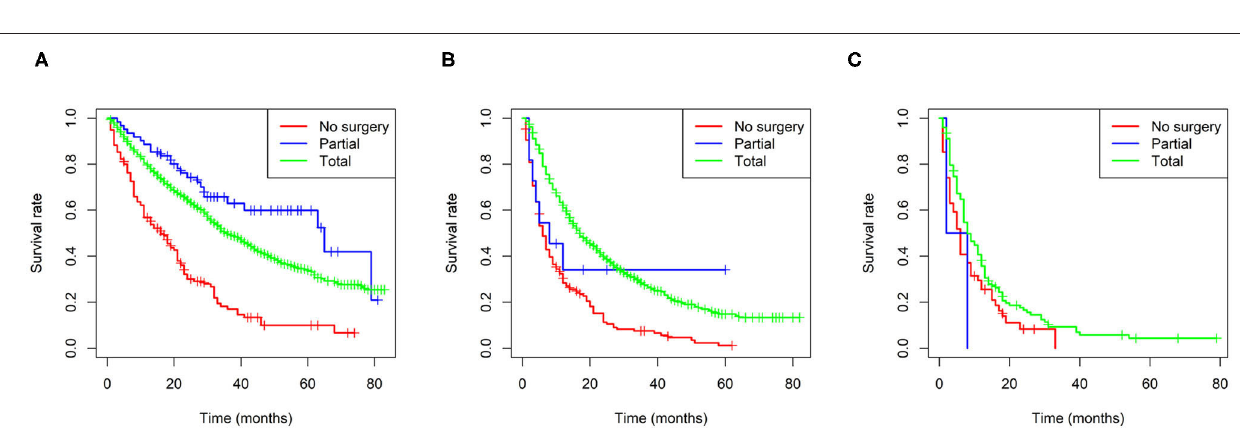
FIGURE 5 | Survival benefit of surgery in the low-risk (A) , intermediate-risk (B) , and high-risk (C)